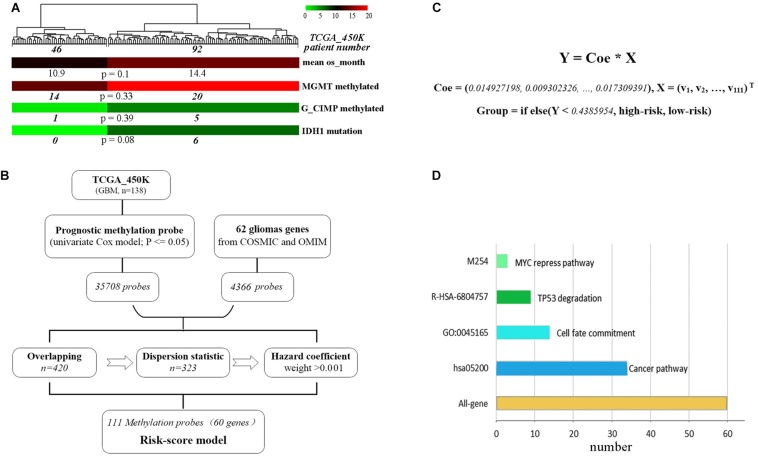
The development of the methylation risk-score signature. (A) GBM clustering by the methylation probes of 62 glioma-tumor genes. (B) Study workflow for the construction of joint-score signature. (C) The joint-score formula constructed with methyl-probe panel. X: β value of the optimal methylated probes. (D) Characteristics of biological function for methyl-probe corresponding genes.